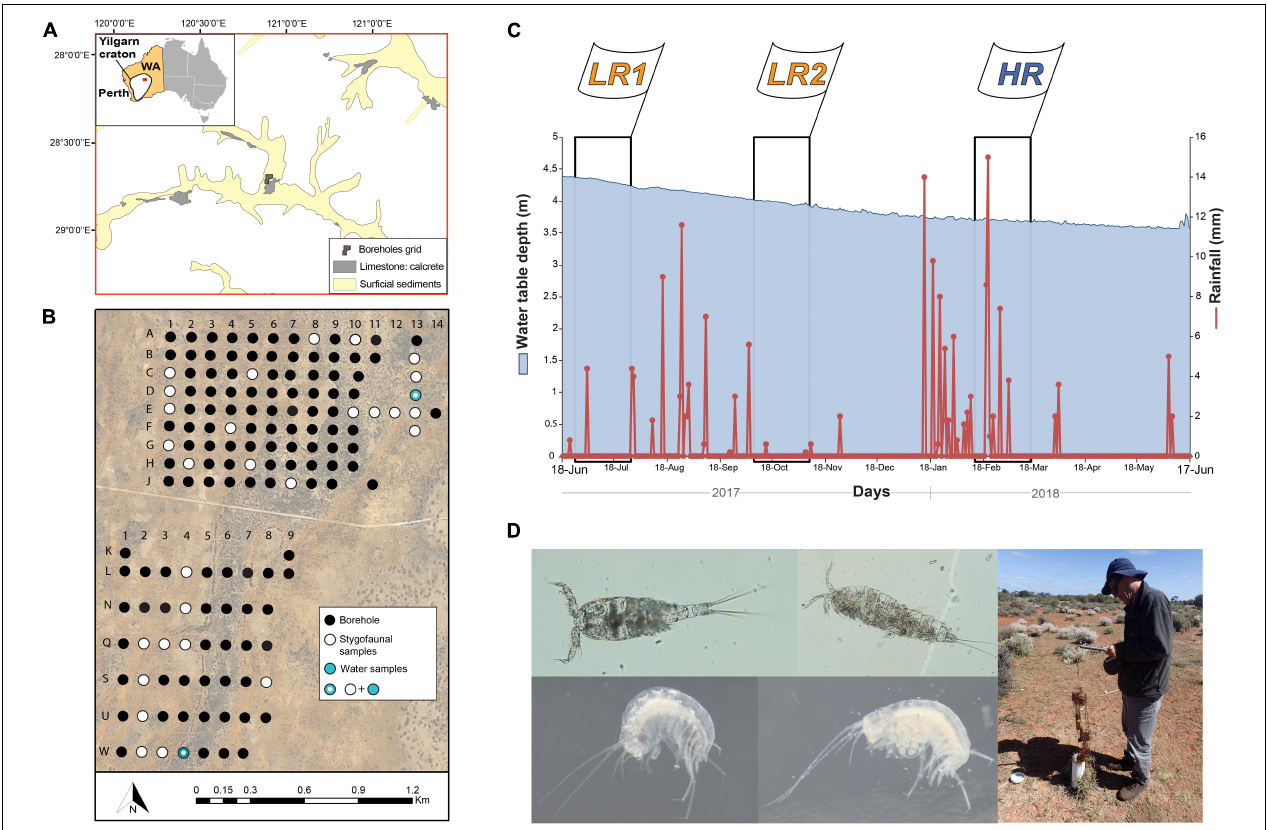
FIGURE 1 | Location the Sturt meadows aquifer (A) and illustration of the borehole grid and samples collected (B) ; weather station data from bore E7 adapted from Saccò et al. (2020b) (C) and (D) photographs illustrating specimens belonging to the taxa Copepoda Cyclopoida (C, top left), Copepoda Harpacticoida (H, top middle), Amphipoda Scutachiltonia axfordi King, 2012 (AM1, bottom left) and Amphipoda Yilgarniella sturtensis (AM2, bottom middle), and also the root material obtained through sample collection in the field (right). Ground water levels (in mm) are illustrated in light blue and rainfall events (in mm) are shown in red in Figure 1C ; flags indicate the dates of LR1 (26/07/2017), LR2 (07/11/2017), and HR (17/03/2018) campaigns, and the black rectangles illustrate the cumulative rainfall and water depth trend for the 30 days before samplings [for rainfall periods category thresholds refer to Hyde et al.